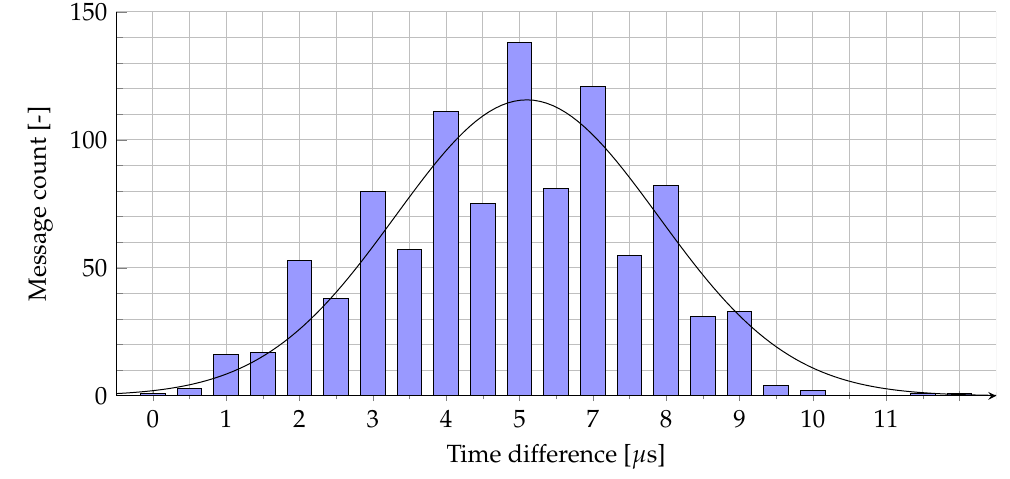
Figure 10. Timestamp fluctuations between 4